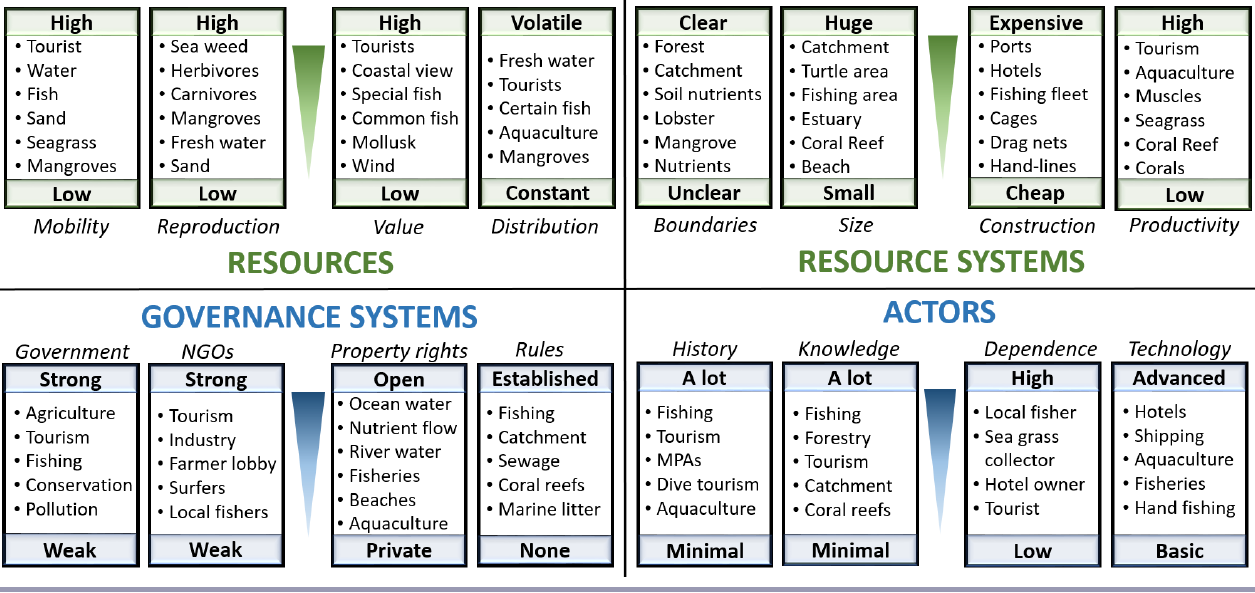
Fig. 2 . Characterizing the unique diversity of coastal systems. Modified from Schlüter et al. (2019). Based on the social-ecological systems framework (McGinnis and Ostrom 2014). The figure conceptualizes the unique spectrum of variables on the coast, and the potential challenges for developing institutions to govern them, including coastal resources, resource systems, actors, and governance systems. Although this heuristic conceptualization is reductionistic, and skewed toward the worldview of scholars linked to the social-ecological systems framework, we believe it is nonetheless valuable as a brainstorming exercise to consider the broad spectrum of contexts that environmental governance theories attempt to explain and are applied